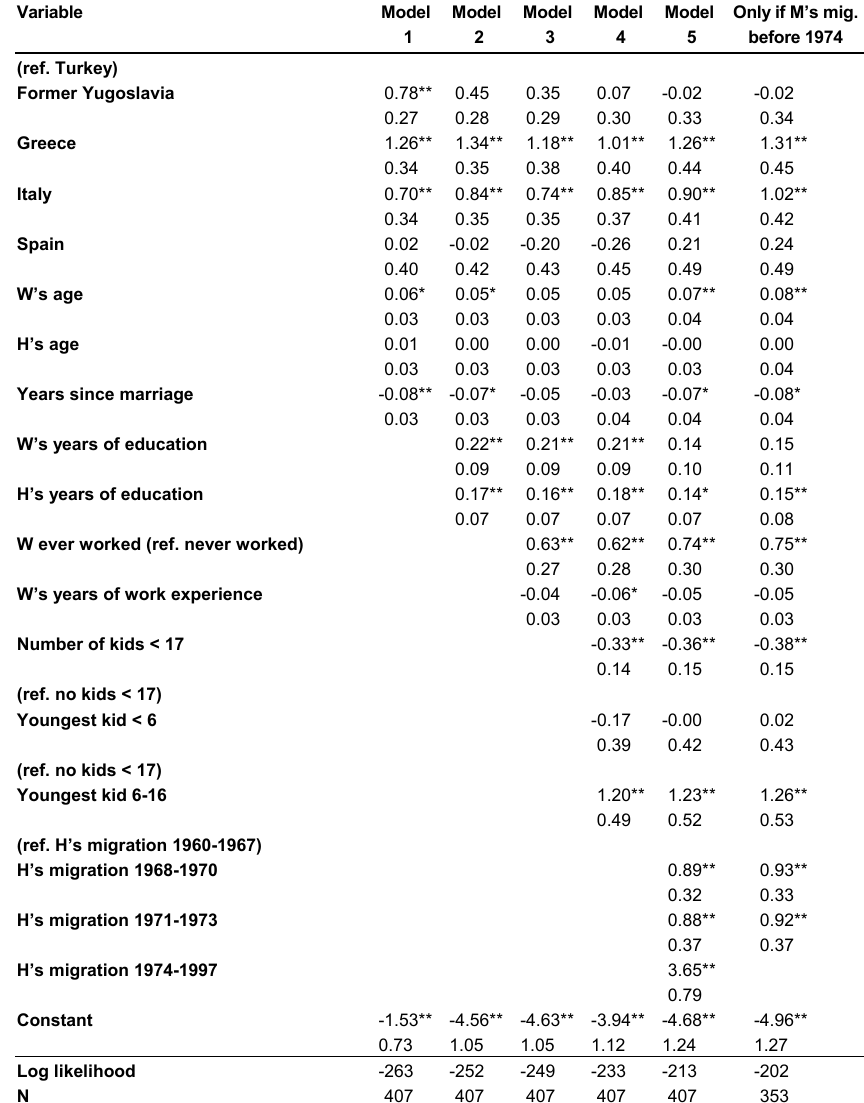
Table 3. Logistic estimates of the likelihood of joint couple migration versus de- layed spouses’